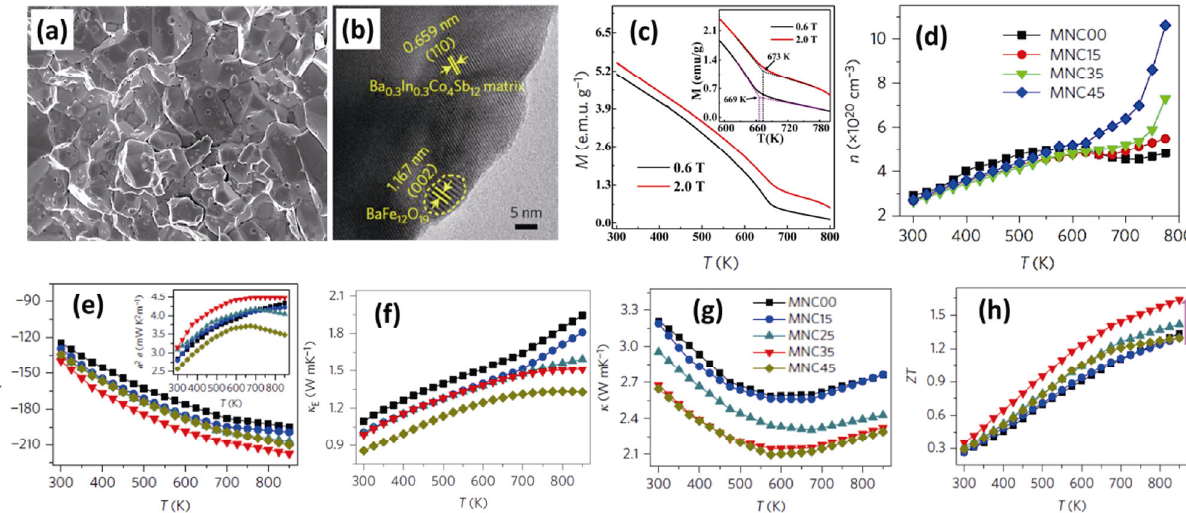
Fig. 11 Performance deterioration of Ba 0.3 In 0.3 Co 4 Sb 12 matrix in the intrinsic excitation region can be suppressed through the magnetic transition of permanent magnet nanoparticles. (a) FESEM image of the 0.45%BaFe 12 O 19 /Ba 0.3 In 0.3 Co 4 Sb 12 (MNC45) magnetic nanocomposite TE material; (b) HRTEM MNC45 sample; (c) Curie temperature of BaFe 12 O 19 nanoparticles; temperature dependences of (d) carrier concentration n , (e) Seebeck coefficient, (f) electronic thermal conductivity κ L , (g) lattice thermal conductivity κ L , and (h) ZT figure of merit of x BaFe 12 O 19 /Ba 0.3 In 0.3 Co 4 Sb 12 . The inset in (e) shows the temperature dependences of power factor ( α 2 σ ) for x BaFe 12 O 19 /Ba 0.3 In 0.3 Co 4 Sb 12 . Reproduced with permission from Ref. [21], © Macmillan Publishers Limited, part of Springer Nature